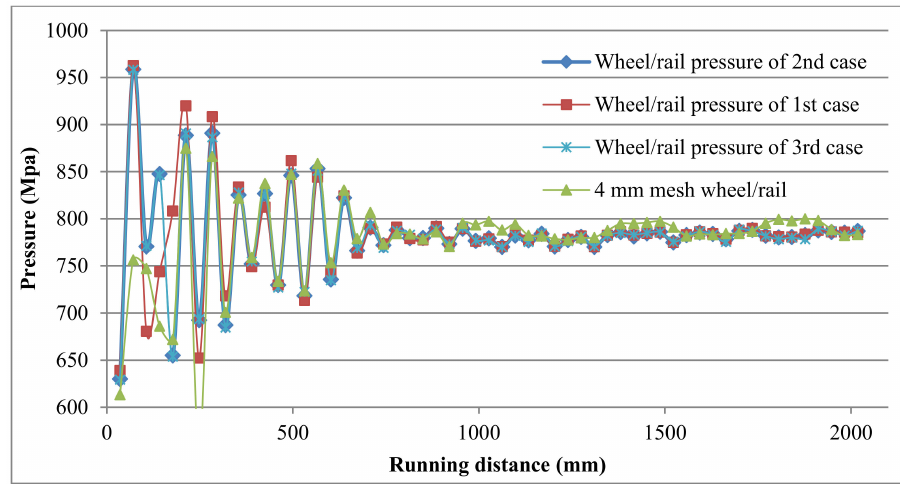
Figure 11. Wheel/rail contact pressure.